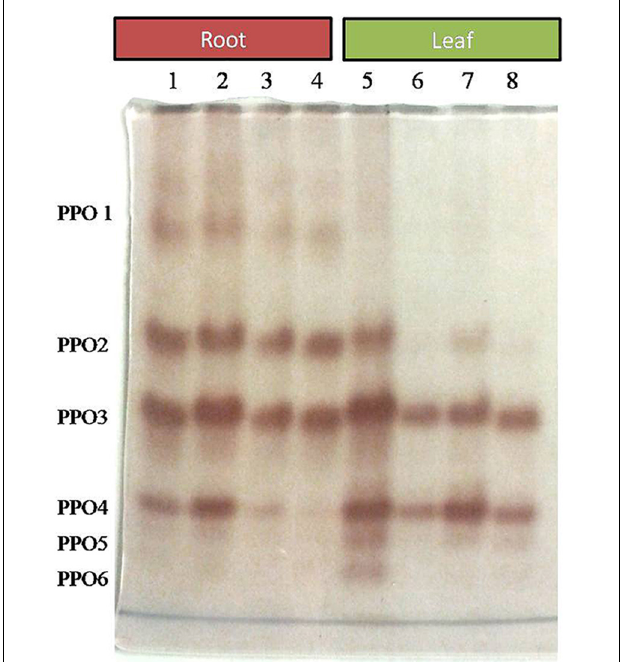
FIGURE 8 | Zymography of PPO isoforms expressed in root and leaves upon bacterial (BHU-AV3) inoculation under salt stress. Lanes 1 and 5 – salt treatment; Lanes 2 and 6 – bacterial (BHU-AV3) inoculation + salt; Lanes 3 and 7 – bacterial inoculation; Lanes 5 and 8 – Control. PPO 1–5 represents number of isoforms